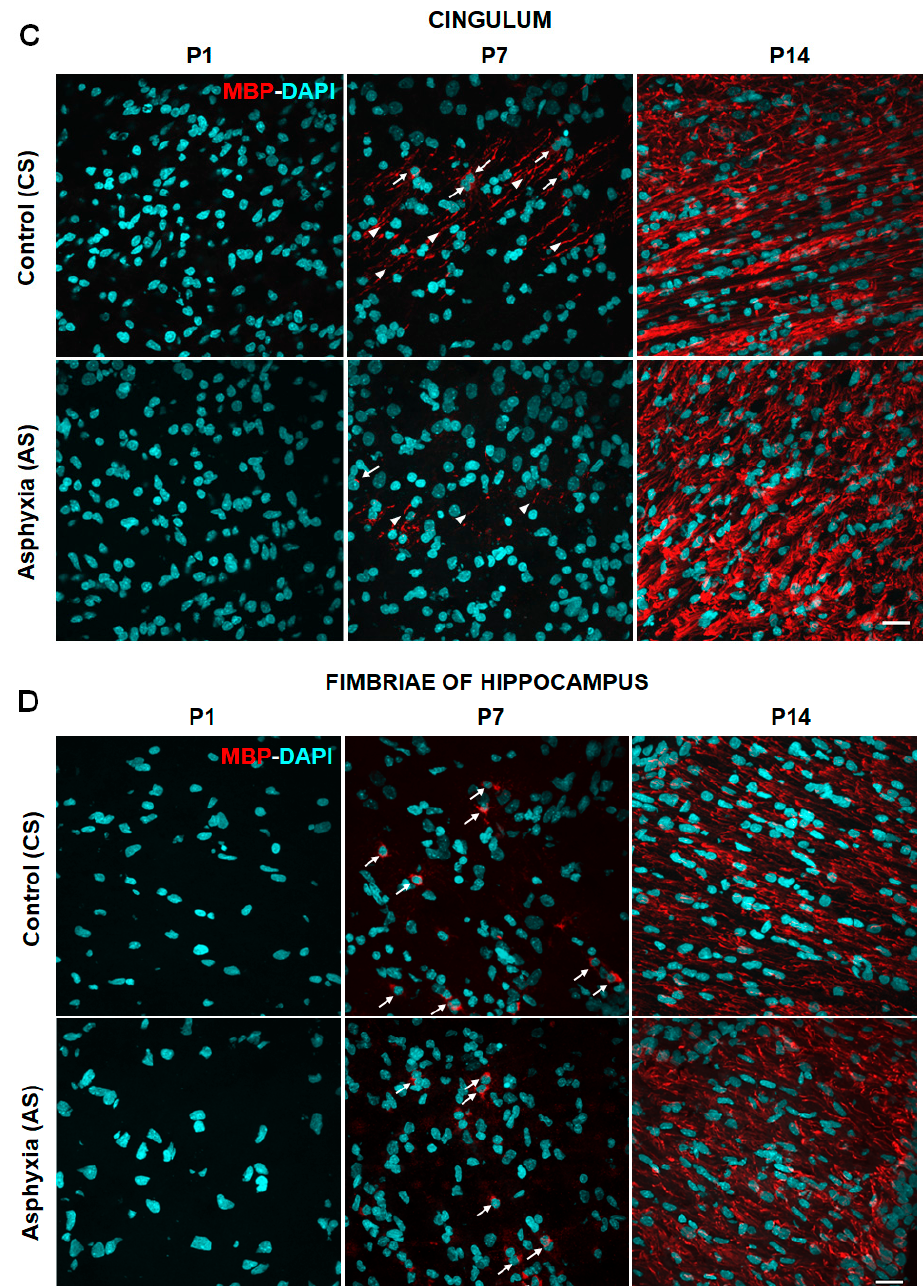
Figure 1. Effect of perinatal asphyxia (PA) and neonatal development on myelination at P1, P7, and P14, measured in external capsule ( A ); corpus callosum ( B ); cingulum ( C ) and fimbriae of hippocampus ( D ) of rat neonates. Representative microphotographs obtained by confocal microscopy showing myelin basic protein (MBP; red) and DAPI (blue; nuclei)- positive cells in external capsule (1A); corpus callosum (1B); cingulum (1C); and fimbriae of hippocampus (1D) from control (CS) and asphyxia-exposed (AS) rat neonates. Microphotographs show MBP, indicating both myelinated fibers and mature oligodendrocytes (OLs). Scale bar: 20 μ m. At P1, no MBP immunoreactivity was observed in any of the analyzed regions and experimental conditions. The density of MBP increased significantly along development. At P7, the density of MBP fibers (white head arrows) was low, letting us visualize individual mature OL (white arrows). In corpus callosum and fimbriae of hippocampus some individual OL can also be seen, showing long and branched processes. In AS, there was a decrease in the density of MBP in external capsule, corpus callosum, and cingulum compared to that in CS. No differences could be seen in fimbriae of hippocampus at P7. At P14 a dense network of MBP fibers can be seen in all regions, but no independent OLs soma can be